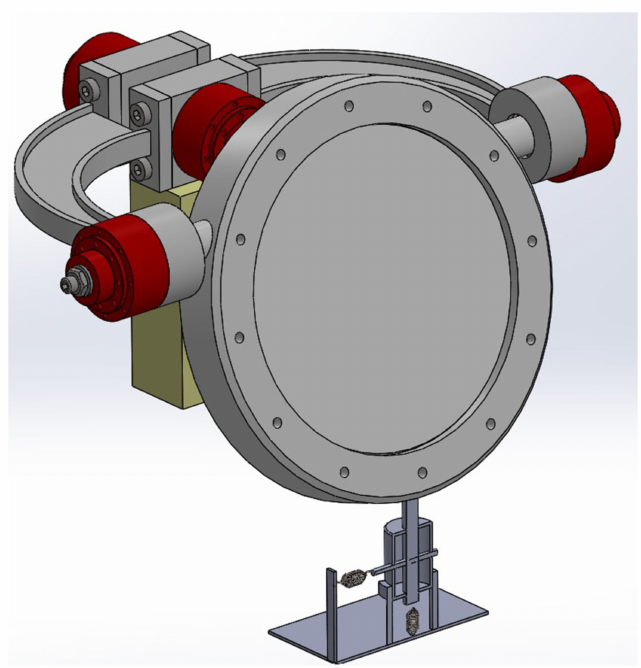
Figure 2. Launch lock and release autonomous mechanisms. The actuated pin collaborates with the structural resistance of the CCR package during the